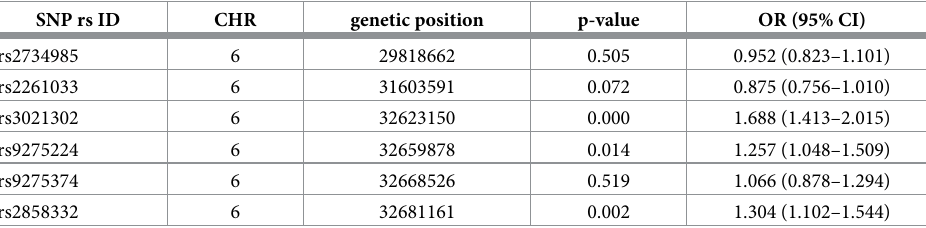
Table 6. Multivariate logistic regression of SS status against MHC